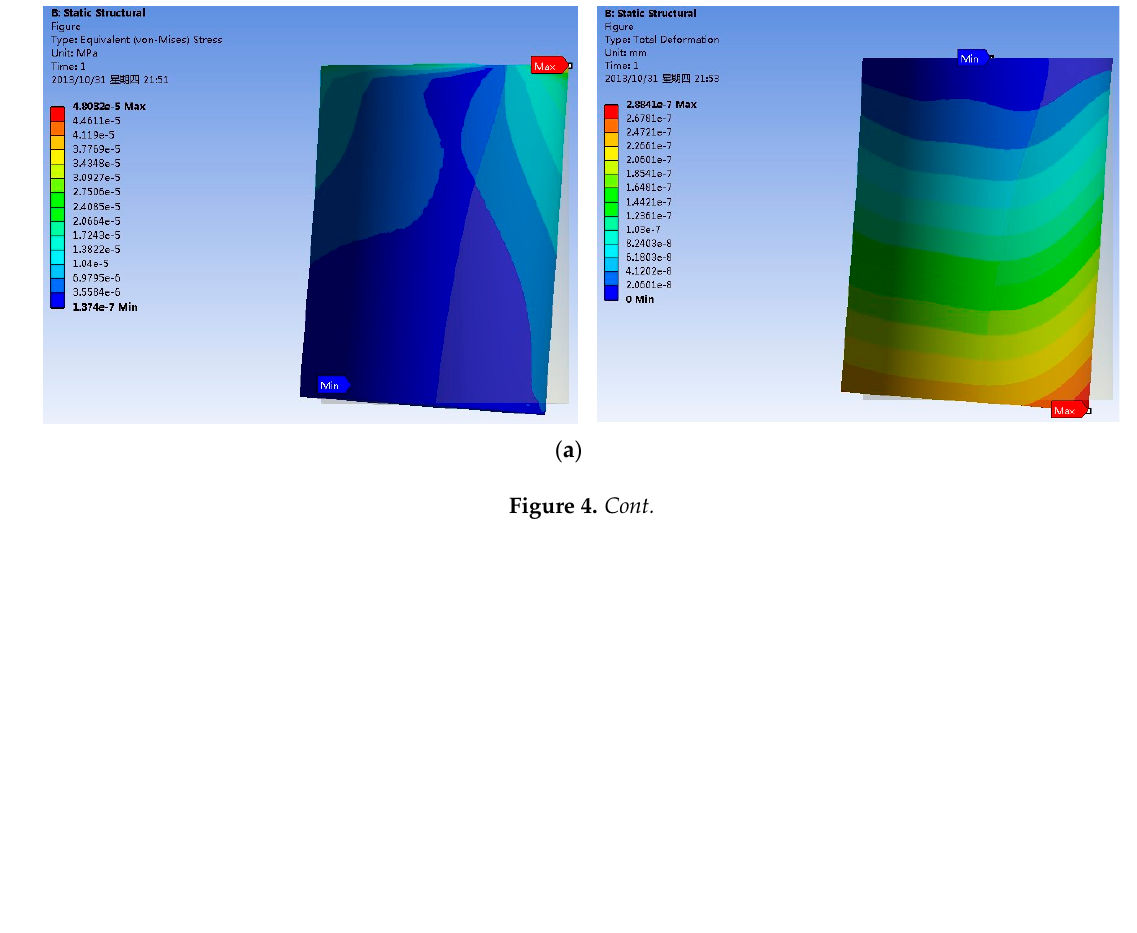
Figure 3. Mesh for floating buoy and fluid field.